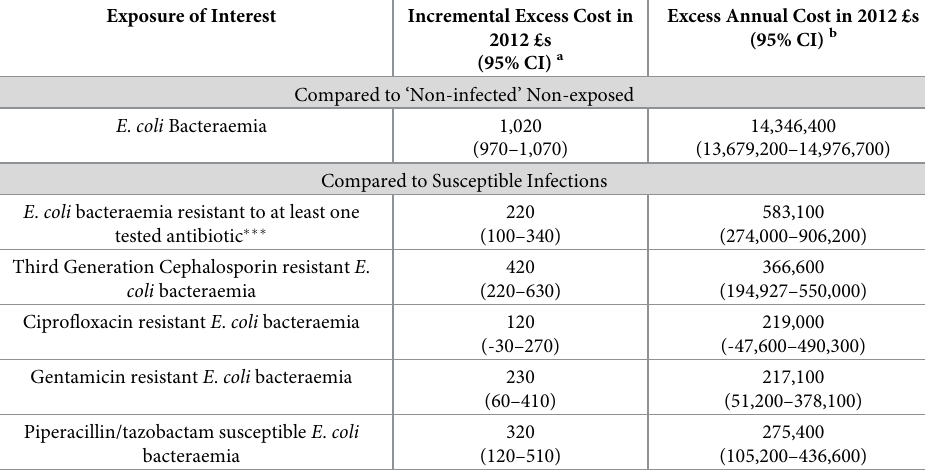
Table 7. Excess costs associated with E . coli